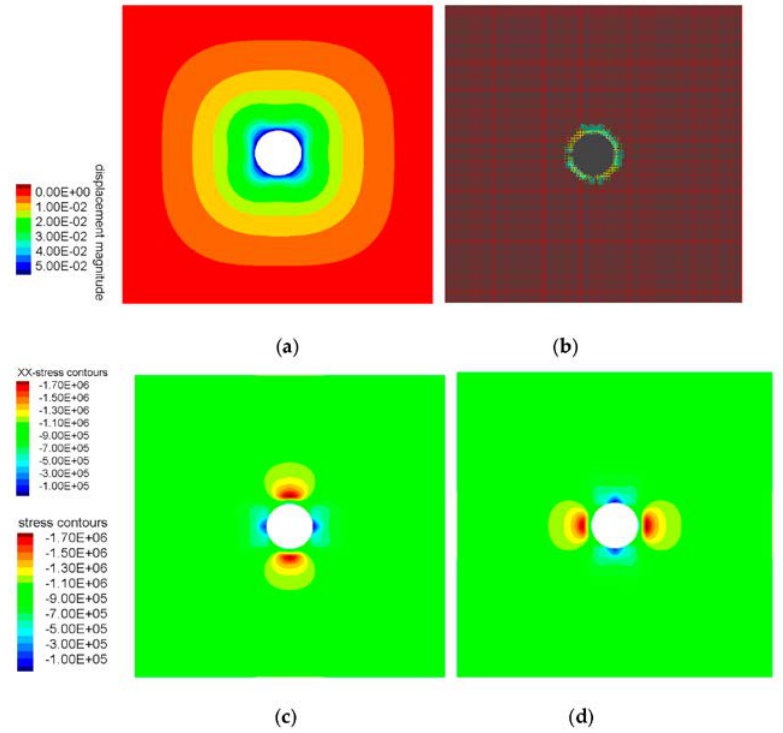
Figure 23. Simulation results for tunnel model with two joint sets (45° and − 45°) and κ = 1: ( a ) displacement contours [m], ( b ) plasticity state, ( c ) contour plot of horizontal stresses [Pa] and ( d ) contour plot of vertical stresses [Pa].